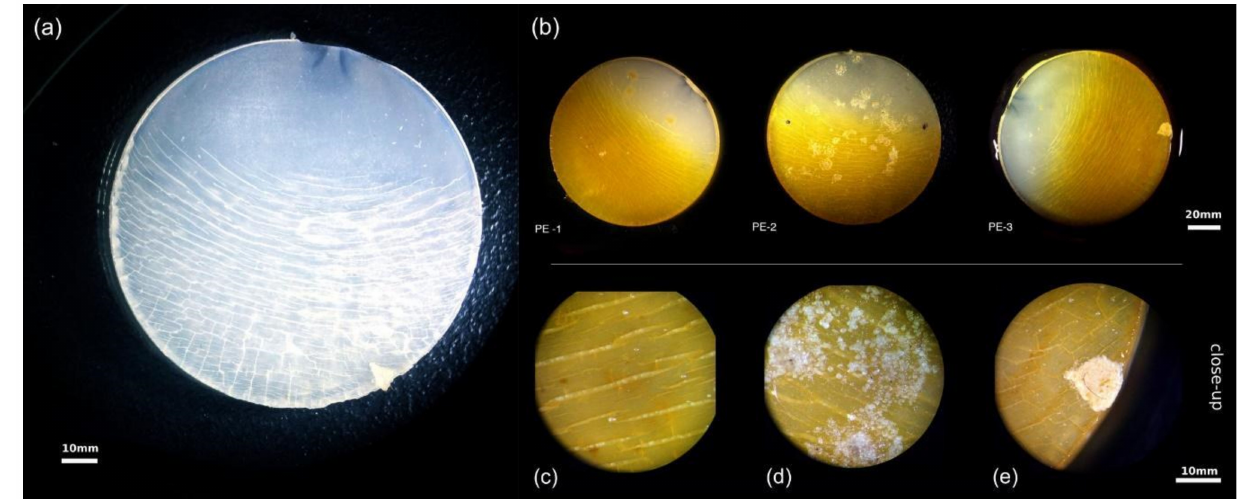
Figure 7. Light microscopy images of PE chips before ( a ) and after 102 days of incubation in batch cultures inoculated with microbial communities from the landfill ( b ). The PE samples show biofilm formations on the surface and inside cracks ( c ). White bacterial aggregates were visible ( d ), and one sample had a firmly attached white colony ( e ). Black dots are pencil marks for